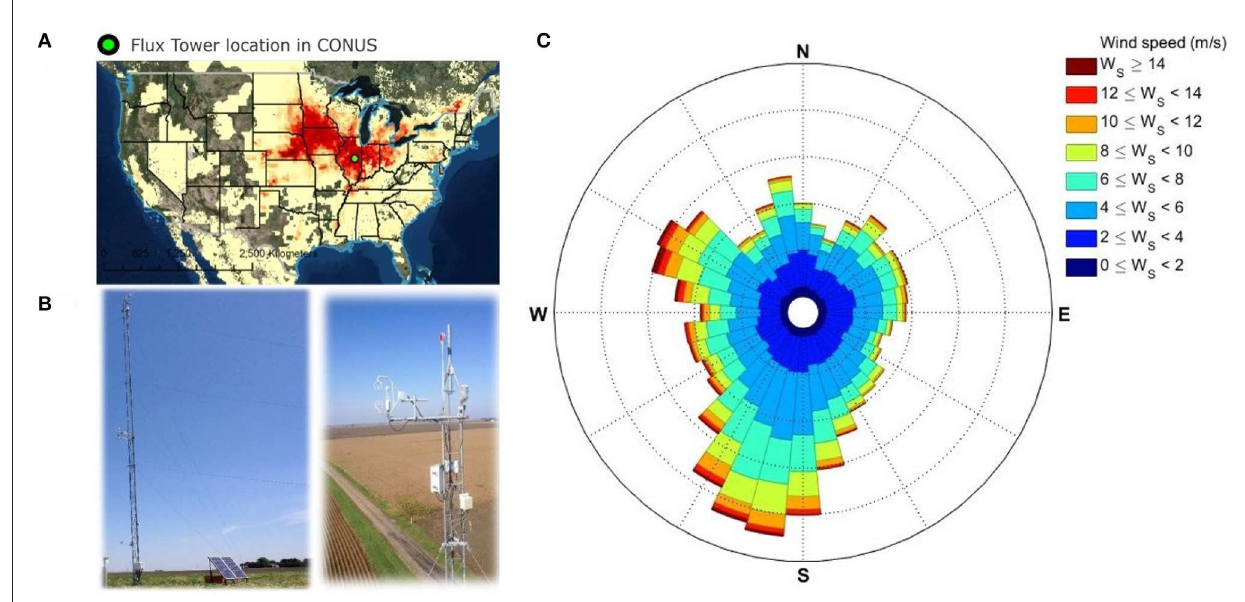
FIGURE1 Goose Creek flux tower location and components. (A) Location of the tower (green dot) and the intensity of maize cultivation [the red area represents the corn harvested area fraction (high = red, low = light ivory); Monfreda et al., 2008]. (B) Fluxes measured by the 25 m tall eddy covariance tower come from the underlying heterogeneous landscape consisting of a mosaic of maize and soybean fields, from a fetch that can reach up to 10 km upwind from the tower. (C) The prevailing wind direction is from the southwest (4/23/2016–4/30/2019). The relative frequency with which the wind blows from a particular direction is proportional to the spoke’s length, and colors indicate different wind speed categories.